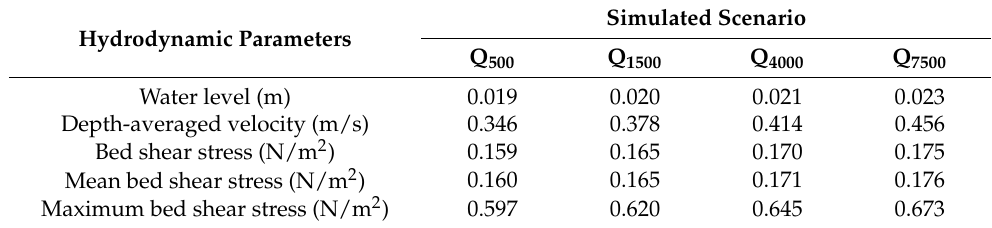
Table 1. Detailed values of modeled hydrodynamic data along 9 cross-sections under four scenarios.